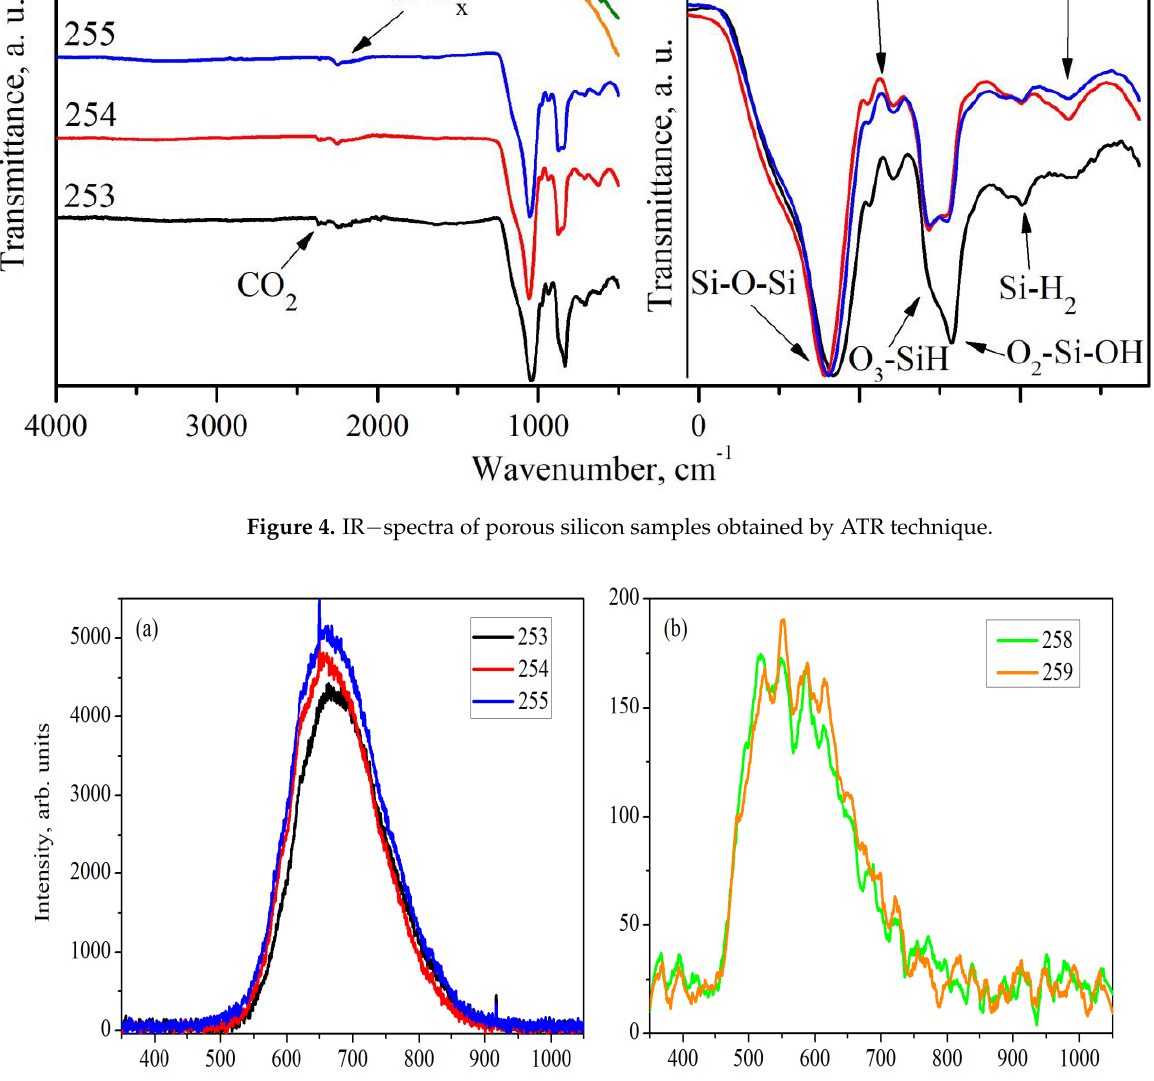
Figure 4. IR−spectra of porous silicon samples obtained by ATR technique.